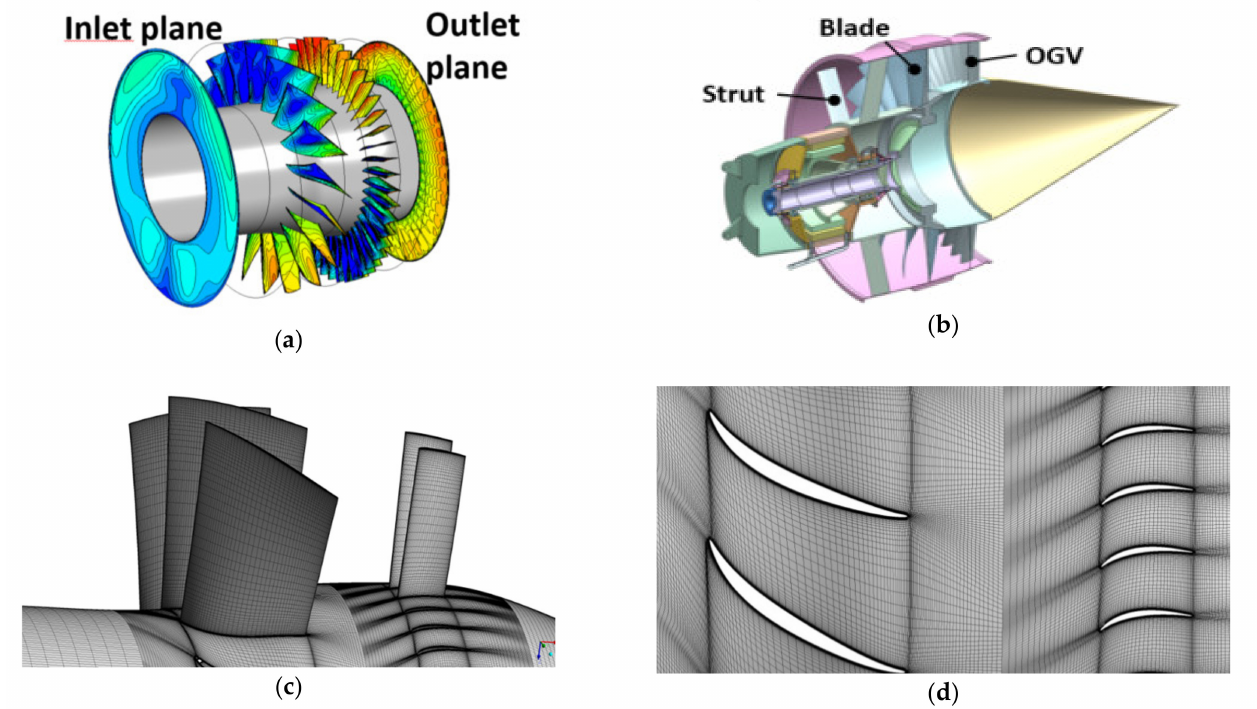
Figure 2. Computational domains. ( a ) Inflow plane to outlet at nozzle; ( b ) overview of fan module; ( c ) meshes over blade surfaces; ( d )mesh showing resolution in the blade-to-blade plane.